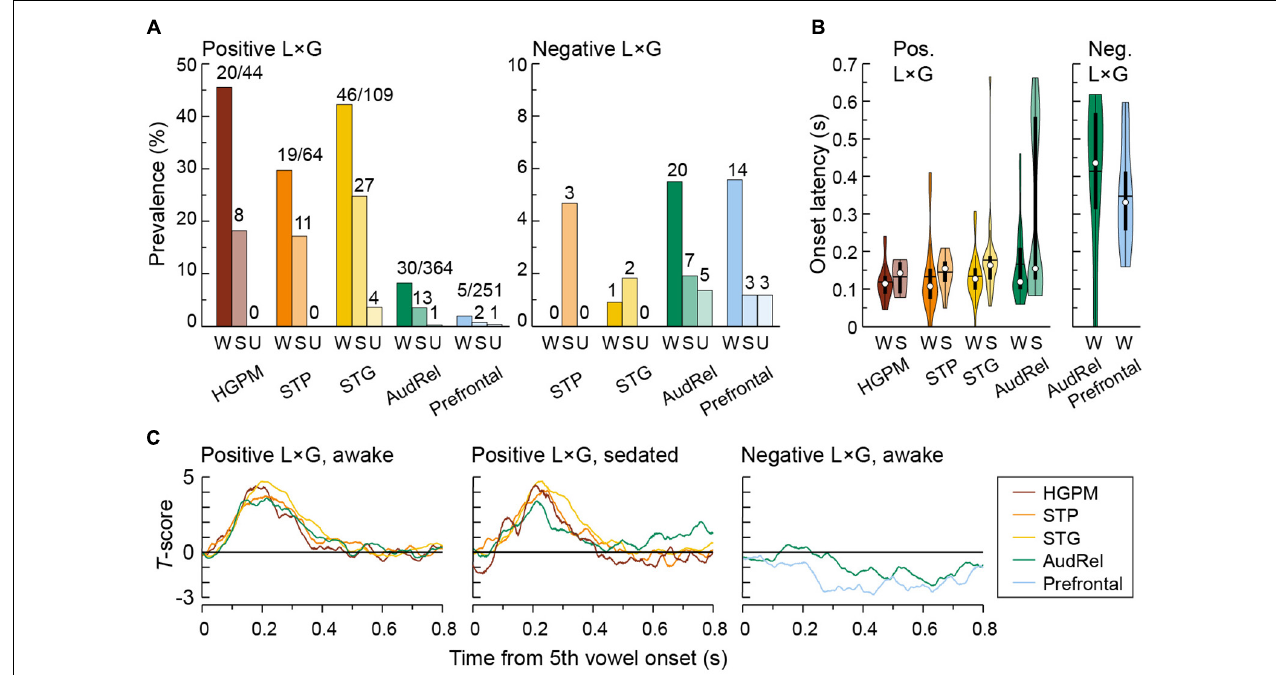
FIGURE 8 | Regional distribution and time course of L × G interactions. Summary of data from seven subjects. Colors represent ROIs, differently shaded bars and symbols represent measurements made in awake (W), sedated (S), and unresponsive (U) state (dark, medium, and light bar shading, respectively). (A) Percentages of sites with significant positive and negative L × G interactions (left and right panel, respectively). Numbers above bars indicate numbers of sites with significant L × G interactions. Note different y -scales in the left and right panel. (B) Onset latencies of positive and negative L × G interactions (left and right panel, respectively). In each violin plot, a white circle denotes the median, a horizontal line denotes the mean, a bar denotes Q 1 and Q 3, and whiskers show the range of lower and higher adjacent values (i.e., values within 1.5 interquartile ranges below Q 1 or above Q 3, respectively). The latency distributions for negative L × G interaction are only shown for the awake state, as very few sites exhibited this interaction in the sedated state (7 and 3 sites in auditory-related and prefrontal cortex, respectively), making statistical inferences impractical. (C) Time course of L × G interactions. T -scores averaged across sites that exhibited significant interactions are plotted as functions of time after the 5th vowel onset. In panels (B,C) , positive L × G interaction in prefrontal cortex and negative L × G interaction in canonical auditory cortex (HGPM, STP, and STG) are not shown due to their paucity in the respective